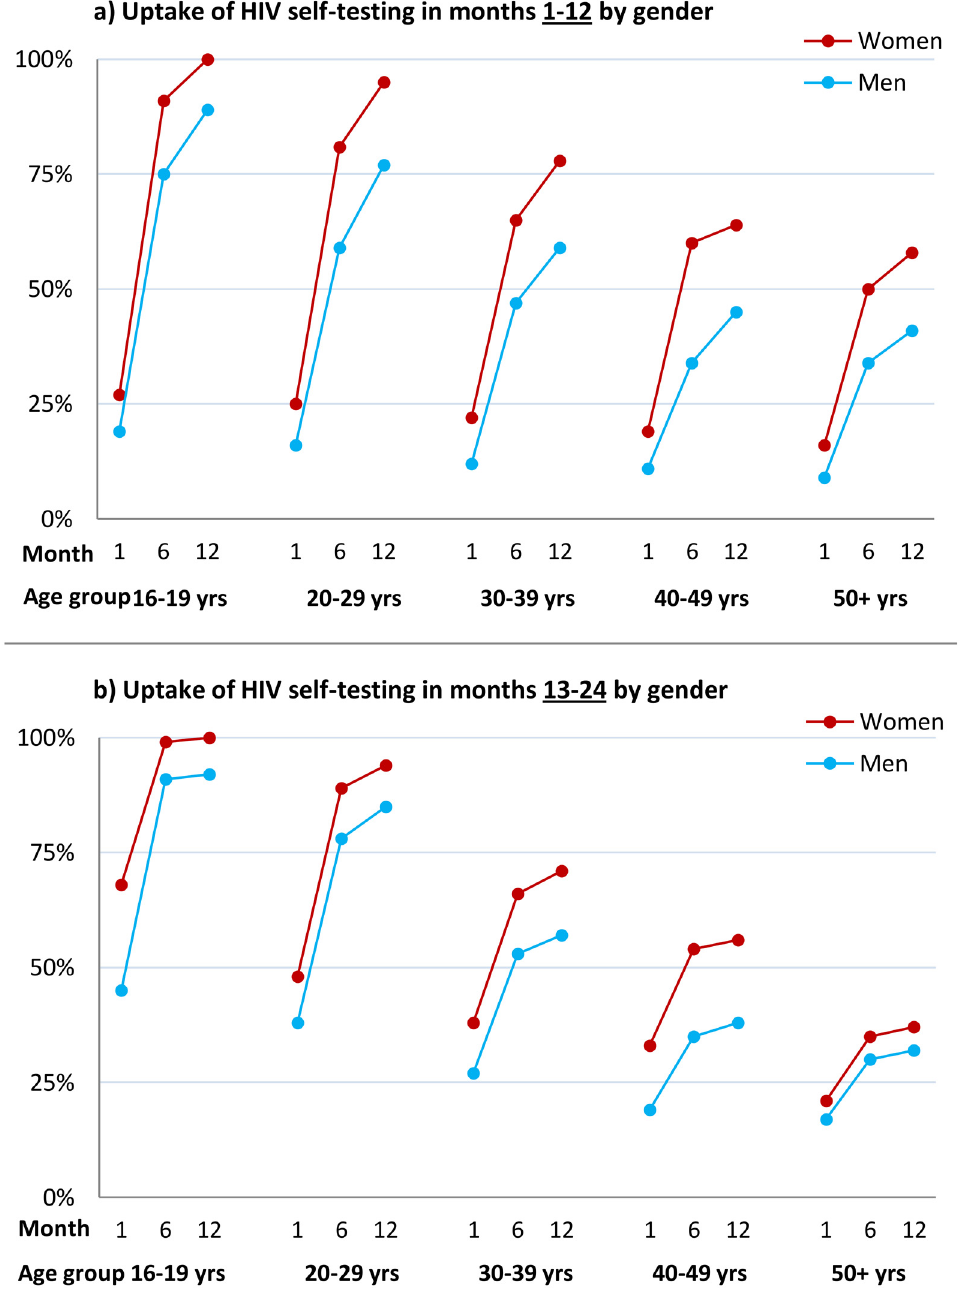
Fig 3. Cumulative uptake of HIV self-testing by sex, age group, and time point. (A) Cumulative uptake of HIVST during the first 12 mo of availability among all HIVST cluster residents by age and time point among men and women. HIVST uptake increased with time, rising to close to 100% by 12 mo in adolescents (age group 16 – 19 y); uptake for men was lower than for women at every time point. (B) Cumulative uptake of HIVST during months 13 – 24 of HIVST availability among all cluster residents by age and time point. Uptake defined as an individual having collected an HIVST kit from a community counsellor. Since crude uptake of HIVST exceeded 100% in some age-sex-neighbourhood subgroups, likely explained by migration, revised estimates were calculated where uptake in any single age-sex-neighbourhood subgroup was censored at 100%; study census data were used for denominators.